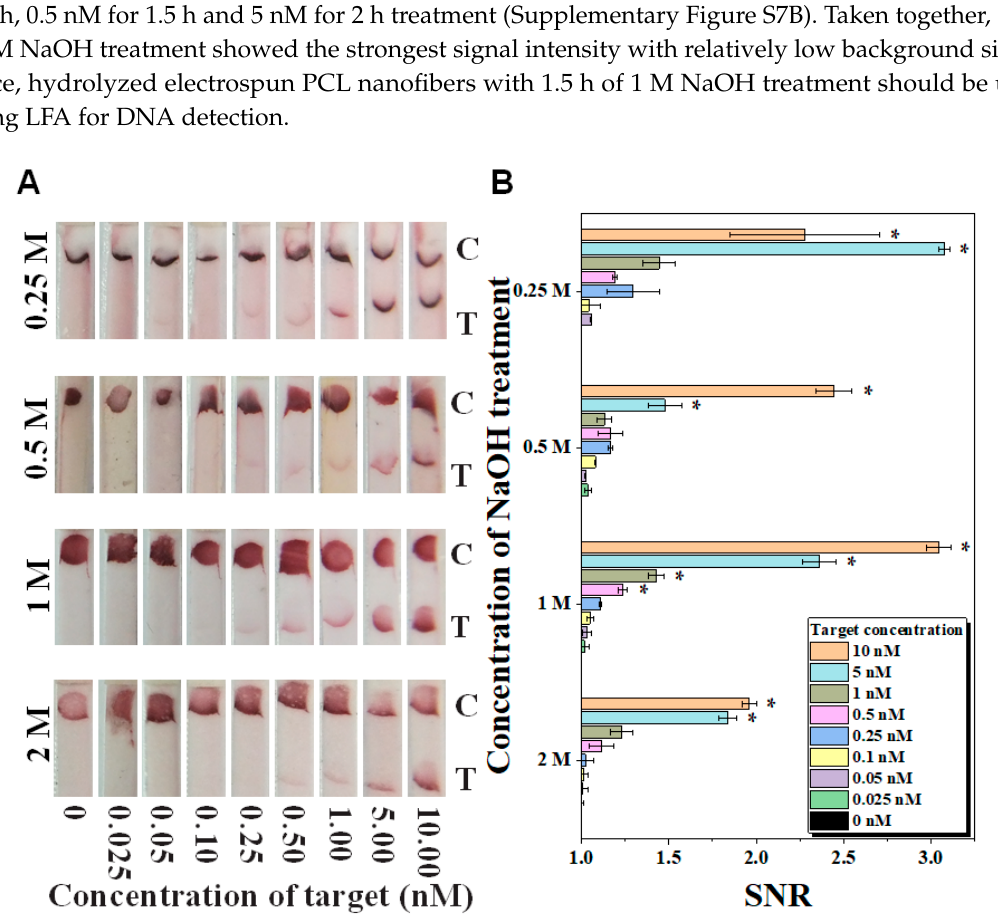
Figure 5. The effect of concentration of NaOH treatment on the performance of lateral flow assay (LFA) integrated with hydrolyzed electrospun PCL nanofibers for the detection of zika viral DNA. Qualitatively, the background or noise signals were stronger at test strips with electrospun PCL membrane treated with NaOH concentration beyond 1 M ( A ); The quantitative results for signal-to-noise ratio (SNR) showed the highest LOD at 0.5 nM for LFA with hydrolyzed electrospun PCL nanofibrous membrane treated with 1 M NaOH ( B ). n = 3. * represents p < 0.05. Table 1. Characteristics of the current hydrolyzed electrospun PCL nanofibers and existing electrospun materials in lateral flow sensing application.